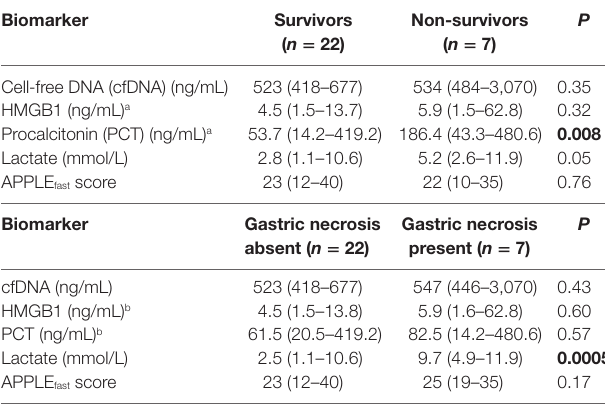
TaBle 2 | Comparison of the variables under analysis in GDV dogs according to final outcome and presence of gastric necrosis. Biomarker